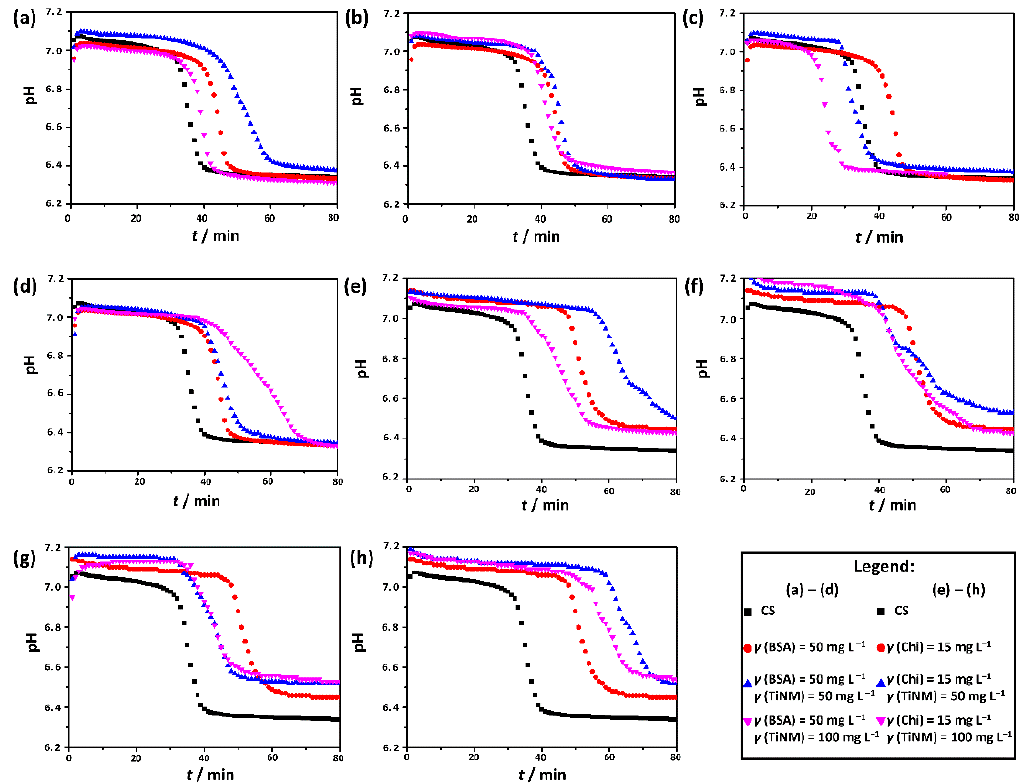
Figure 2. Representative pH vs. time curves obtained in the control system (CS) and in the presence of ( a – d ) 50 mg L − 1 BSA and ( e , f ) 15 mg L − 1 of chitosan (Chi) and different concentrations of TiO 2 nanomaterials: ( a , e ) TiO 2 nanoparticles (TiNPs), ( b , f ) TiO 2 nanoplates (TiNPls), ( c , g ) titanate nan- otubes (TiNTs), ( d , h ) nanowires (TiNWs). C (CaCl 2 ) = c (Na 2 HPO 4 ) = 4 × 10 − 3 mol dm − 3 , pH init = 7.4, ϑ = (25 ± 0.1) ◦